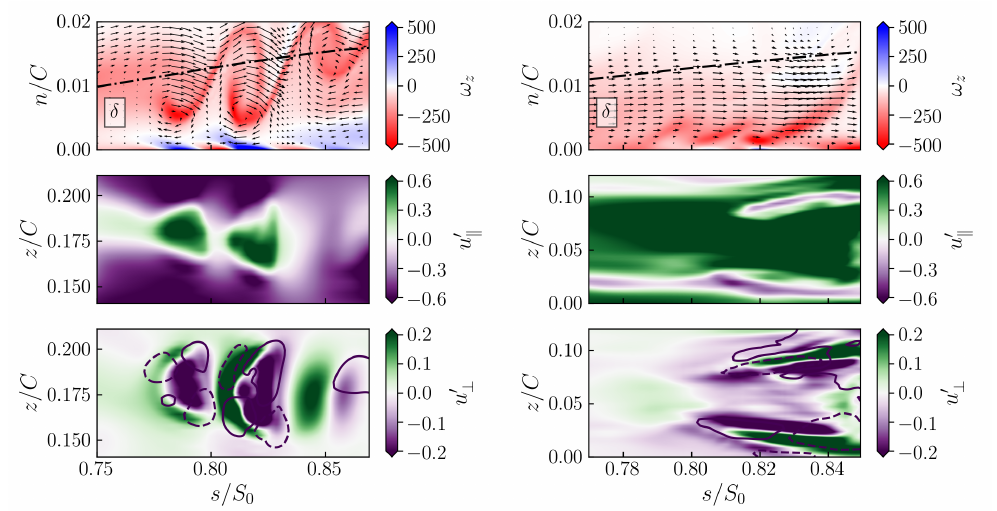
Figure 4. Instantaneous suction surface statistics for Re 2 = 86,000 in the regions identified by the black dashed boxes of Figure 3. The top subfigure shows spanwise vorticity in the blade-normal plane denoted with dash-dotted lines of Figure 3, superimposed with fluctuating velocity vectors. n / C = 0.01 away from the wall. The solid and dashed lines in the bottom subfigures are iso-lines of w (cid:48) = 0.15. ( Left ): ϕ = 0.25; ( right ): ϕ = 0.625. ±